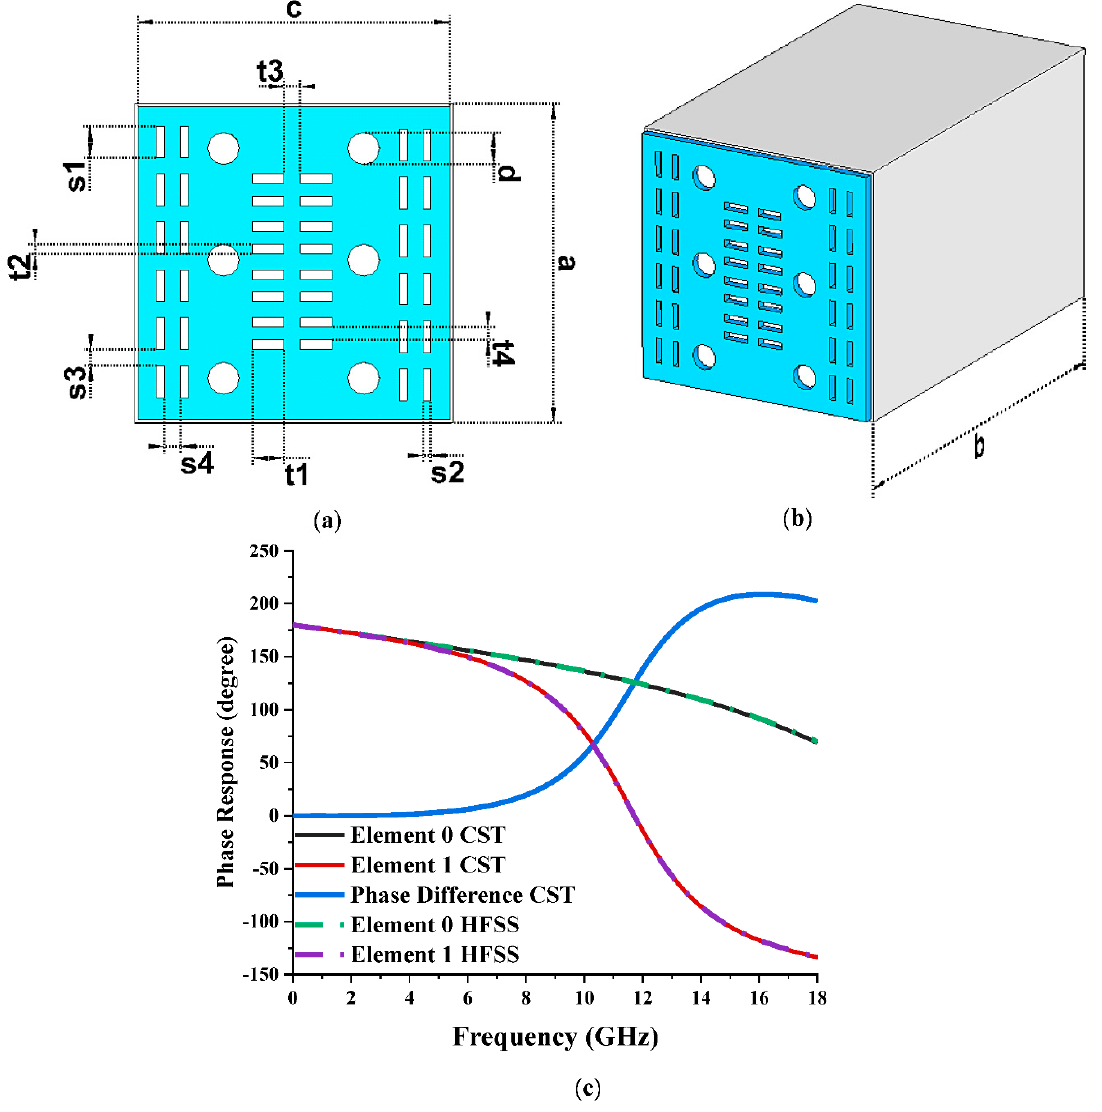
Figure 1. Numerical simulation geometry: ( a ) front view; ( b ) side view; ( c ) phase responses of elements ‘0’ and ‘1’.